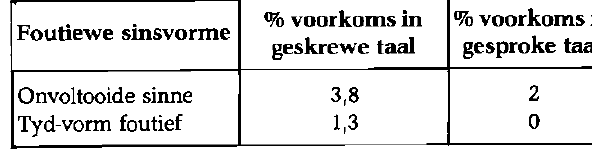
Die verkree resultate van die proefpersone se geskrewe en gesproke sintaktiese vermoens word vervolgens bespreek.